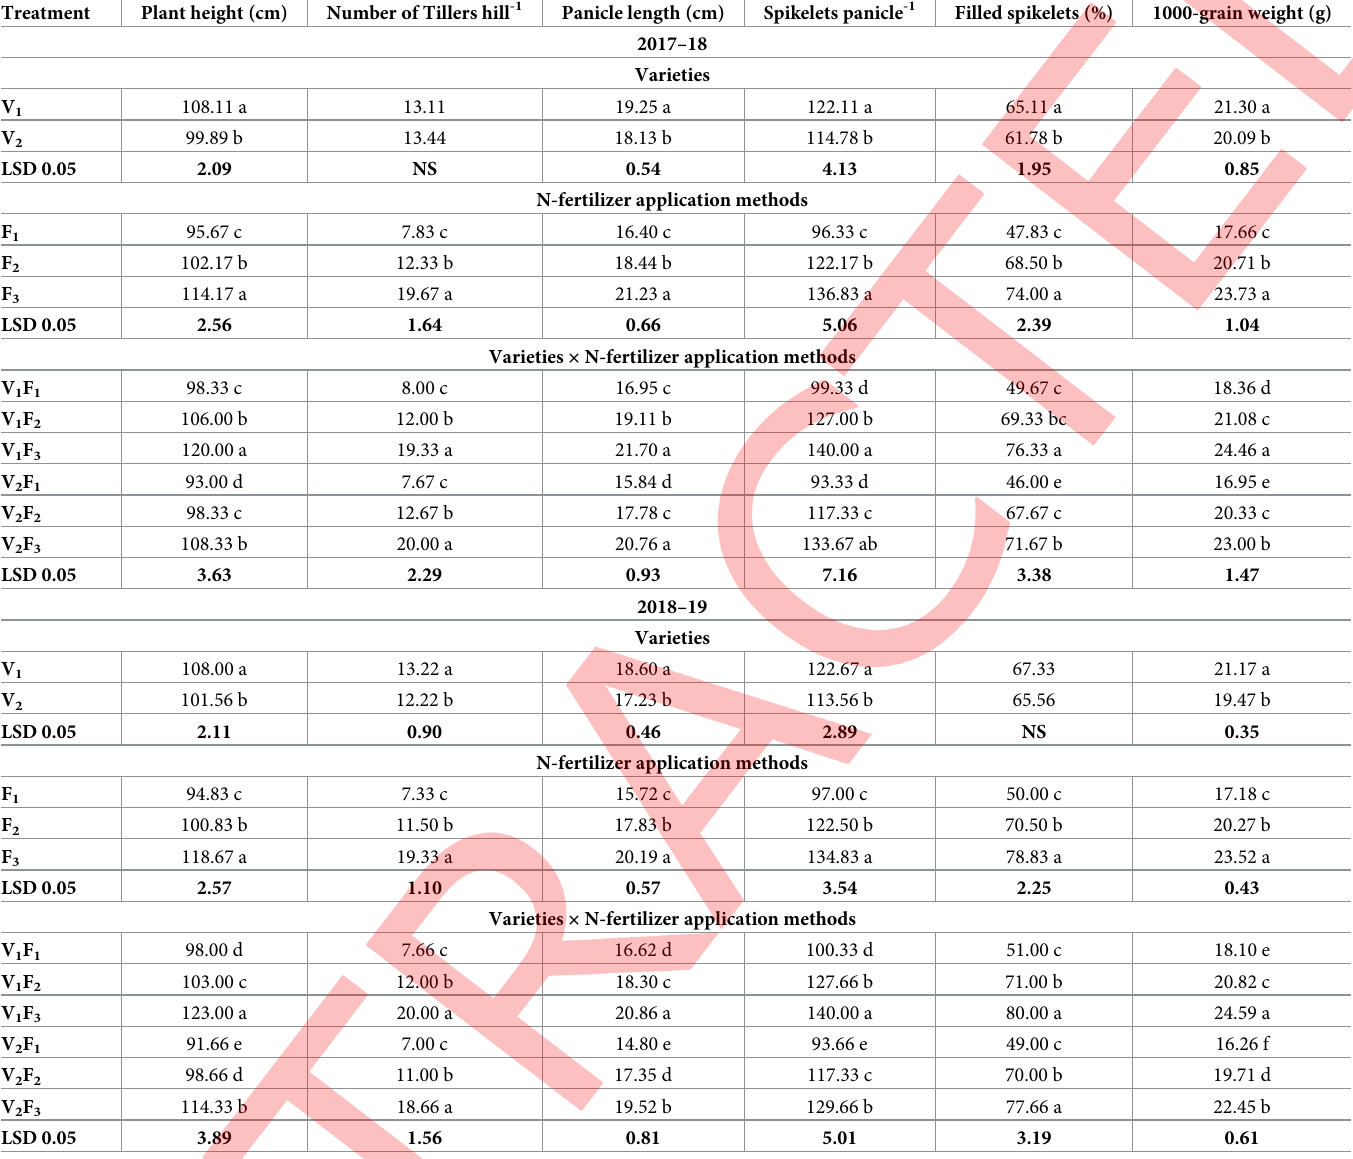
Table 2. The impact of different nitrogen fertilizer application methods on growth and yield-related traits of transplanted fine rice. Treatment Plant height